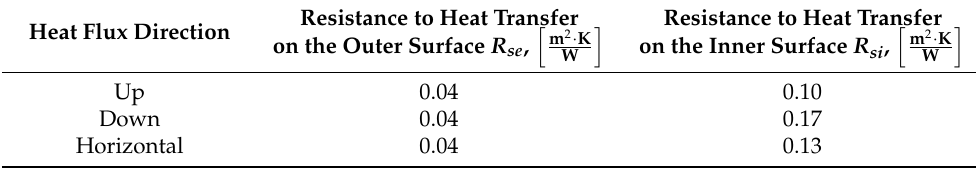
Table 3. Values of the coefficients R se and R si .